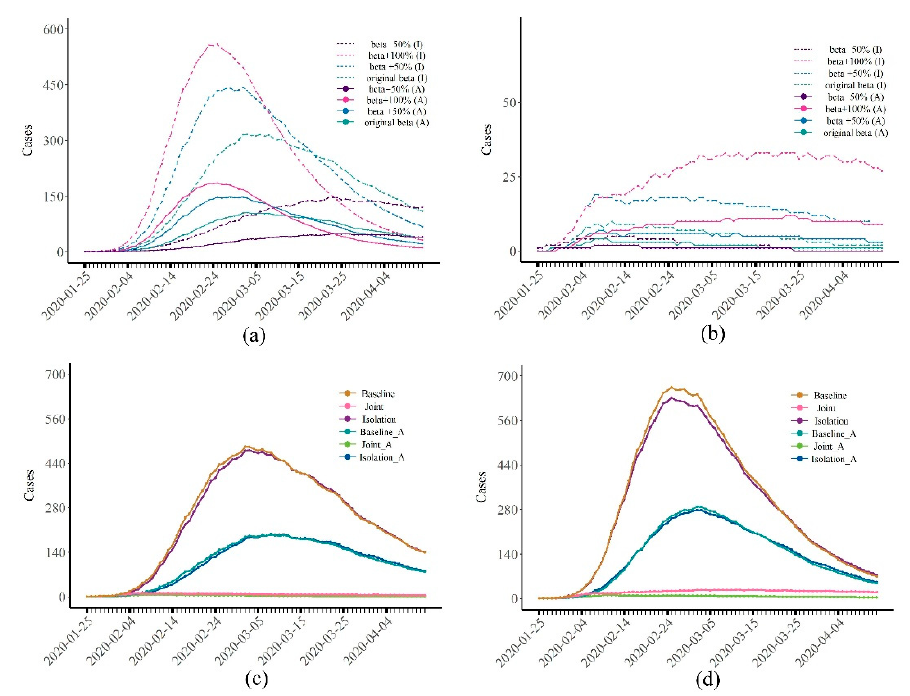
Figure 5. ( a , b ) Results of the ( a ) isolation and ( b ) joint interventions under four transmission rates; ( c ) transmission rate of COVID-19 and ( d ) sensitivity analysis to asymptomatic infections when the transmission rate increased by 50%; ( c ) results of COVID-19 and ( d ) theoretical infectious disease when the transmission rate increased by 50%. Baseline, Isolation, and Joint denote an epidemic of infectious diseases when there were no asymptomatic infections. Baseline_A, Isolation_A, and Joint_A denote an epidemic of infectious diseases when the proportion of asymptomatic infections increased to 50%. Isolation refers to Isolation 6 in Table 1 and Joint refers to Joint 4 in Table 1.